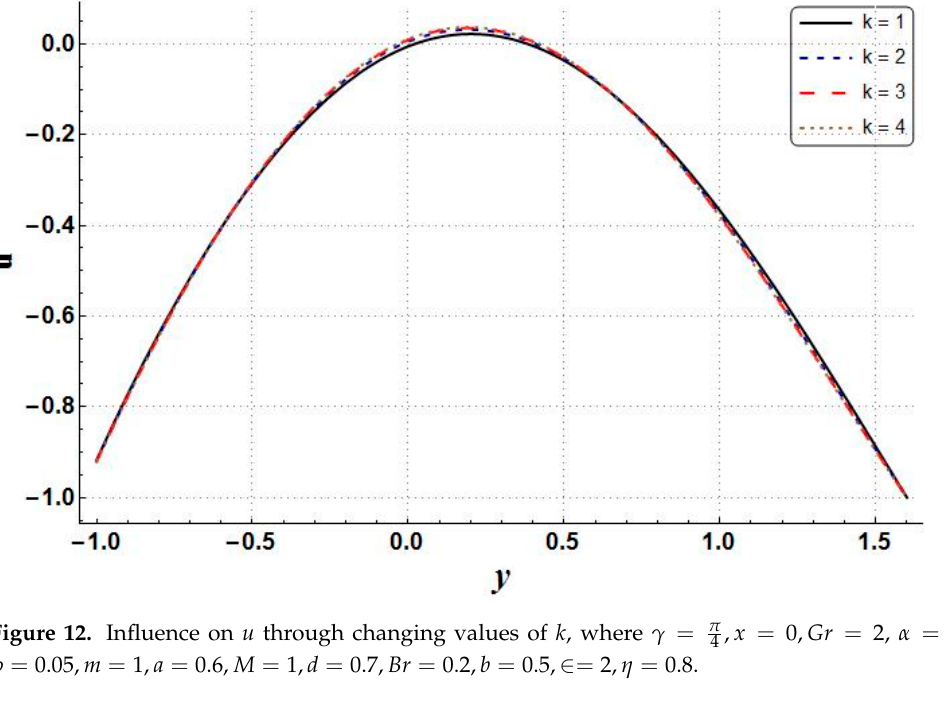
u through changing values of